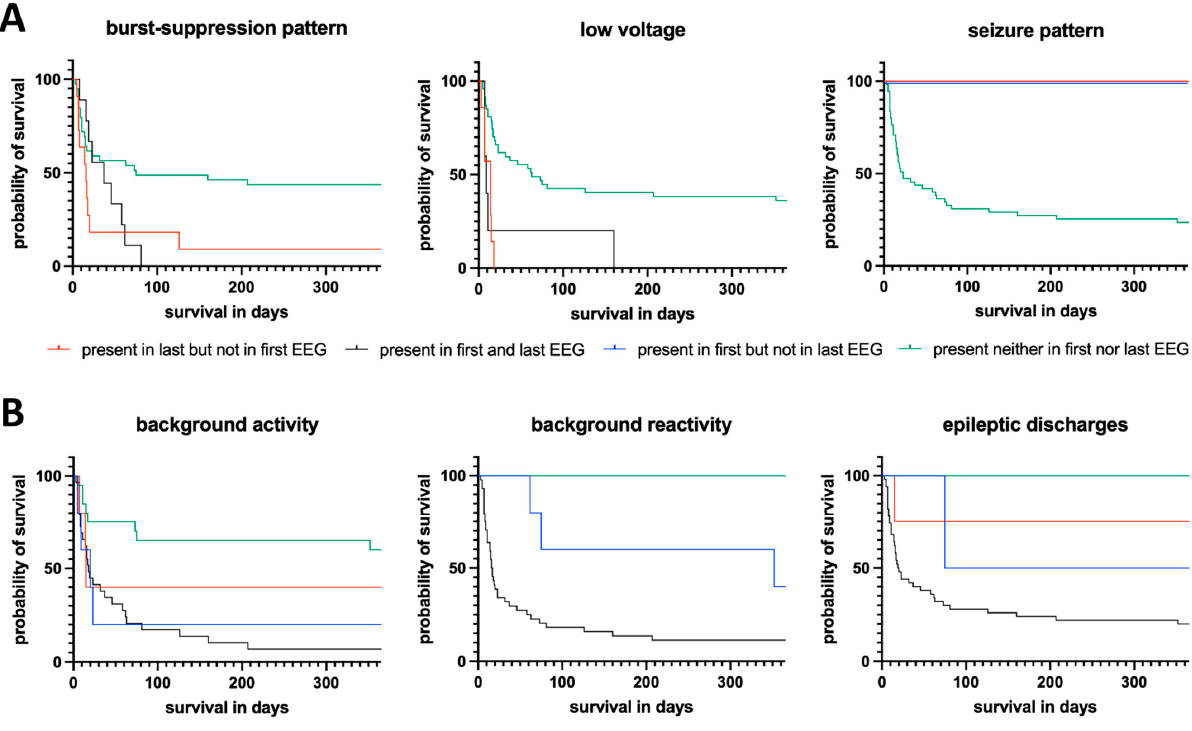
Figure 3. Kaplan–Meier survival diagram illustrating the influence of altered EEG findings between the first and last EEGs within 14 days after CPR in adult patients with HE. The log-rank test showed a significant difference between the subgroups in terms of 12-month survival for all examined EEG features, except for seizure pattern (see Table 3). Due to the different benignity or malignity of the existing EEG pattern, the color of the legend changes between the subfigures A and B (see paragraph 2.3). Table 3. Univariate analysis of predictive properties of rEEG parameters in patients with HE after CPR (n = 59).